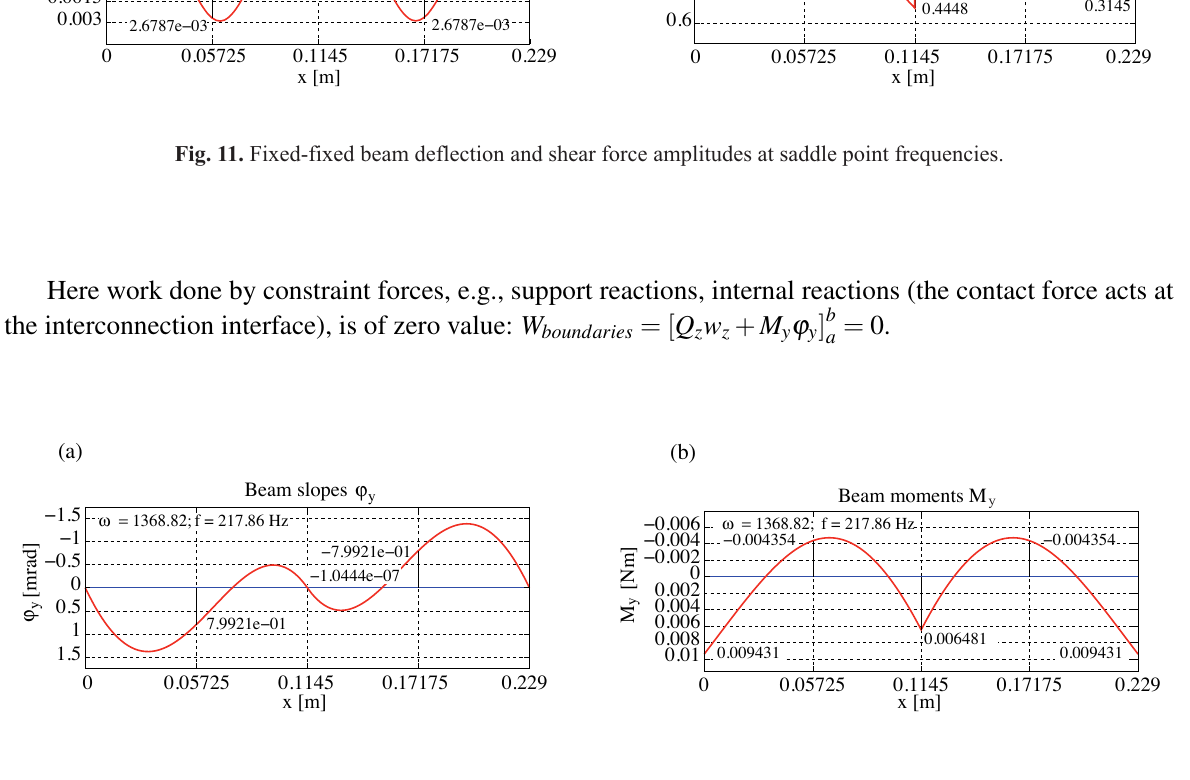
Fig. 12. Fixed­fixed beam slope and bending moment amplitudes at saddle point frequencies. ( Continued on the next page.